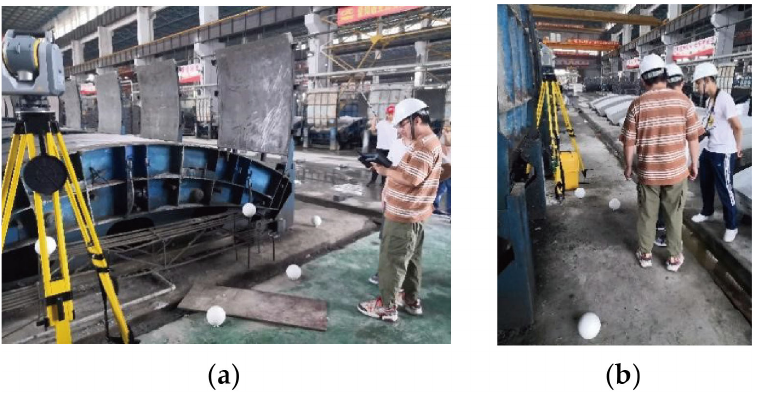
Figure 1. Scanning being performed at a tunnel segment factory in the Panyu District, Guangzhou, China: ( a ) scanning of a mold for the segment production; ( b ) scanning of the segment.